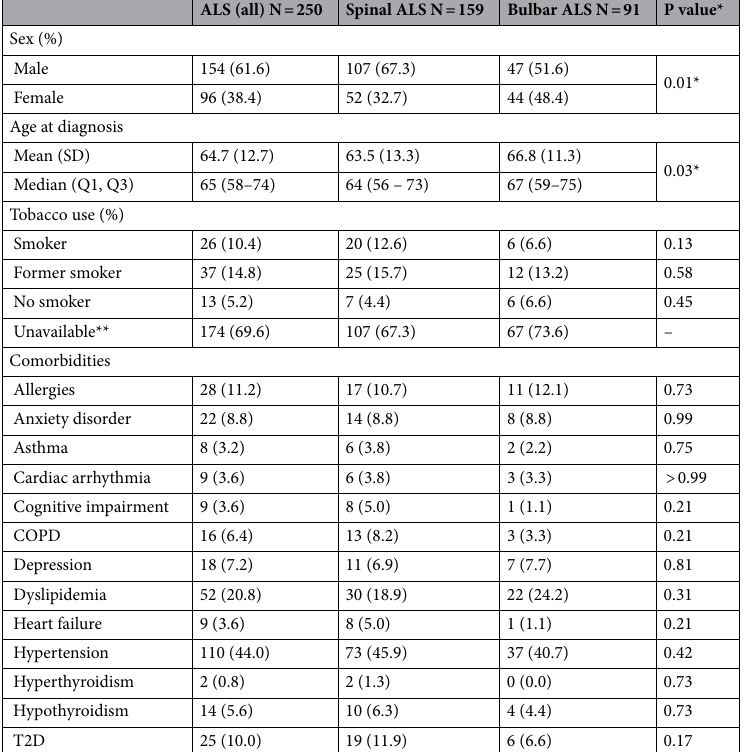
visits to different hospital services prior to diagnosis (Table 2). The most visited services and departments at this stage were primary care (88.4%; n = 221) and emergency room (38.4%; n = 96), whereas neurology was the most visited specialist service (38.8%; n = 97). Next, we analyzed the occurrence of symptoms before diagnosis and at baseline. As shown in Table 3, the most common symptoms until diagnosis were weakness (38.0%; n = 95), followed by dyspnea (21.6%; n = 54),